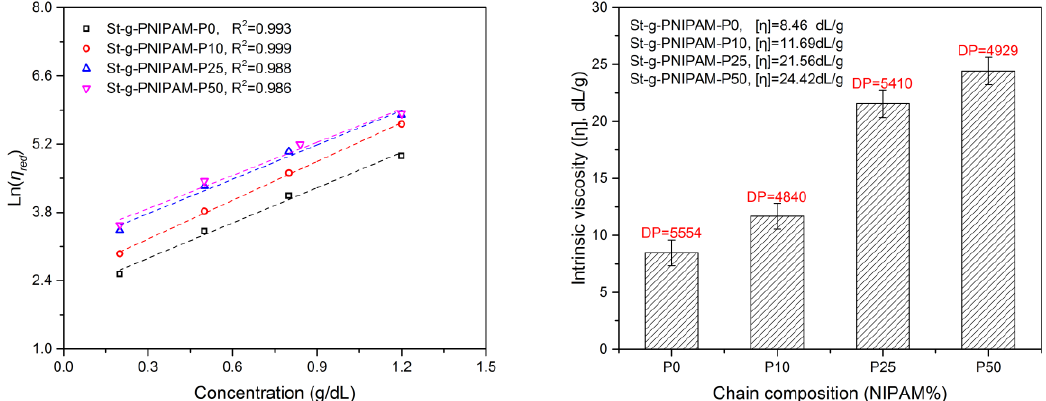
Figure 2. Reduced viscosity as a function of copolymer concentration (Martin’s equation) ( Left ) and corresponding intrinsic viscosity ( Right ).